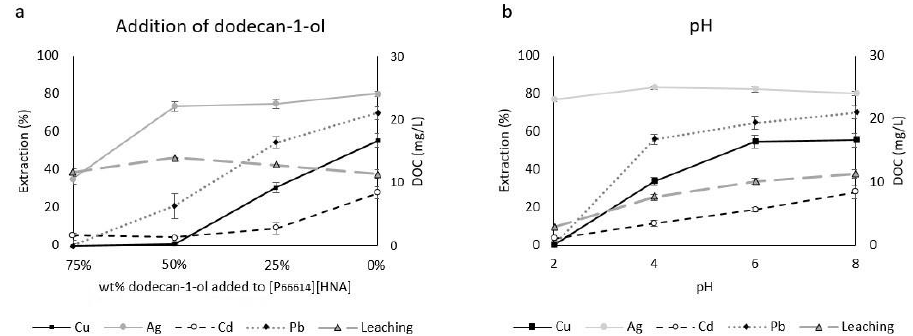
Figure 1. Effects of ( a ) adding dodecan-1-ol at pH 8.0 and ( b ) the pH using pure [P 66614 ][HNA] on